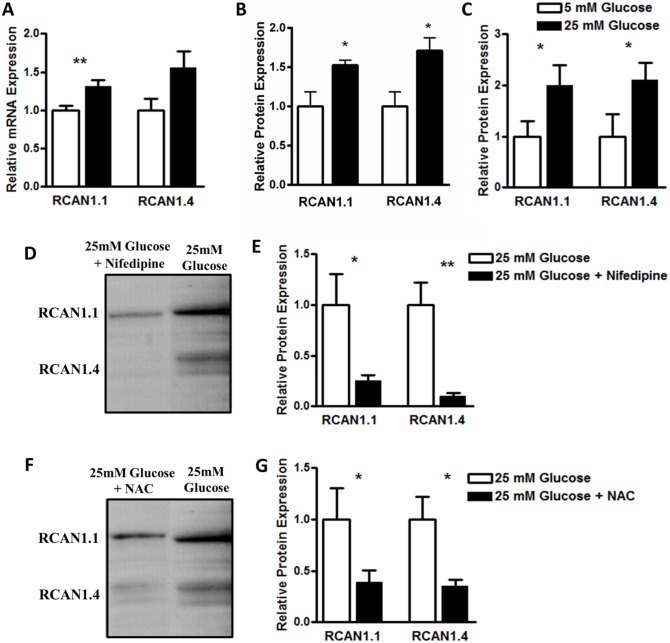
β-cell RCAN1 expression is increased under hyperglycemic conditions via Ca2+ and oxidative stress.(A) RCAN1.1 expression (mRNA) is significantly higher in human pancreatic islets cultured at 25 mM glucose (black bars) when compared to islets cultured at 5.5 mM glucose (white bars) (n = 5 experiments). (B) RCAN1.1 and RCAN1.4 expression (protein) is significantly higher in mouse pancreatic islets cultured at 16.7 mM glucose (black bars) when compared to islets cultured at 5.5 mM glucose (white bars). (n = 4 experiments). (C) RCAN1.1 and RCAN1.4 expression (protein) is significantly higher in MIN6 cells cultured at 25 mM glucose for six days (black bars) compared to cells cultured at 5 mM glucose (white bars) for the same time period, (n = 5 experiments). (D) Representative Western blot showing reduced RCAN1.1 and RCAN1.4 expression in MIN6 cells cultured at 25 mM glucose +Nifedipine for 6 days compared to cells cultured at 25 mM glucose for the same time period. (E) Quantification of Western blot images, (n = 5 experiments). (F) Representative Western blot showing reduced RCAN1.1 and RCAN1.4 expression in MIN6 cells cultured at 25 mM glucose +NAC for 6 days compared to cells cultured at 25 mM glucose for the same time period. (G) Quantification of Western blot images, (n = 5 experiments). Data represents the mean ± SEM, *p<0.05, **p<0.01.